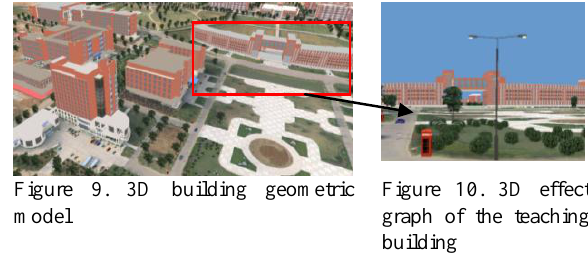
Figure 10. 3D effect